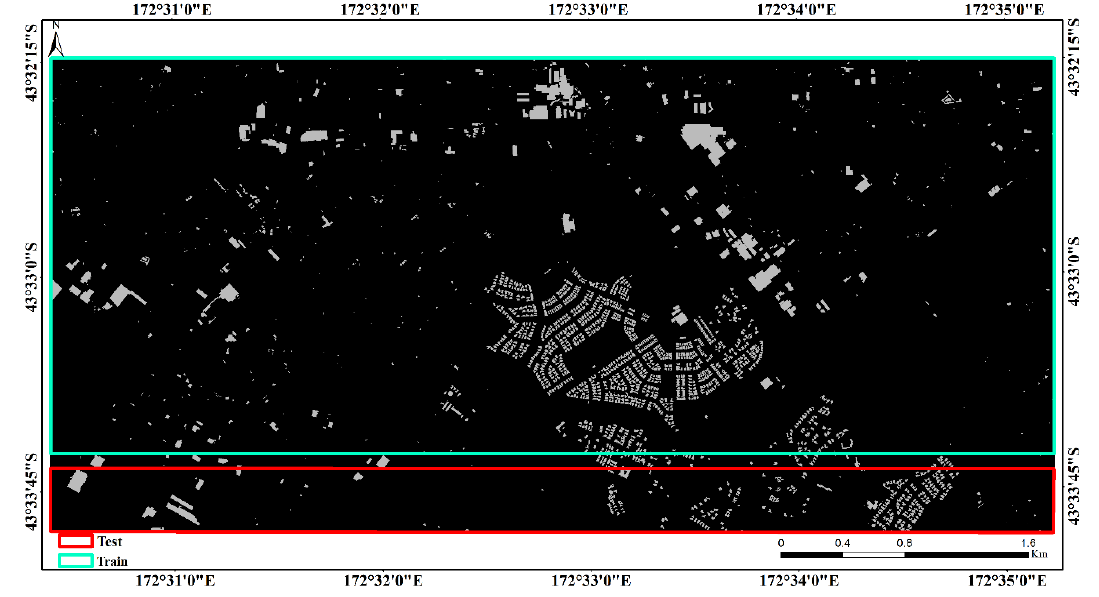
Figure 5. Overview of the dataset.